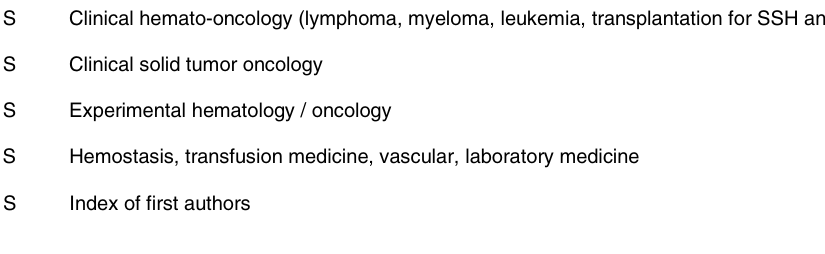
2 S Clinical hemato-oncology (lymphoma, myeloma, leukemia, transplantation for SSH and SSMO) 11 S Clinical solid tumor